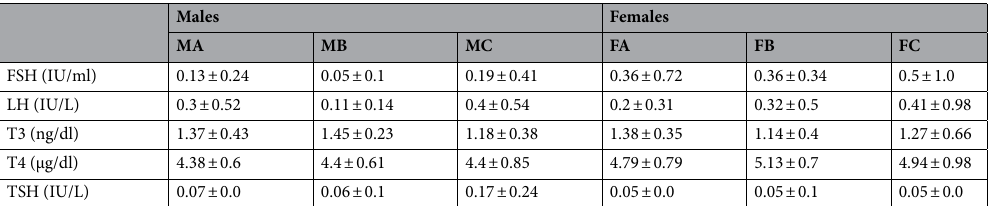
Table 4. Hormonal analysis in the studied groups on the 90th day. Each value is presented as the mean ± SD. MA: male rats with Tarom molaii rice feeding, MB: male rats with GM Bt rice feeding, MC: male rats with standard feeding, FA: female rats with Tarom molaii rice feeding, FB: female rats with GM Bt rice feeding, FC: female rats with standard feeding. FSH: follicle stimulating hormone, LH: luteinize hormone, T3: triiodothyronine, T4: thyroxin, TSH: thyroid stimulating hormone.